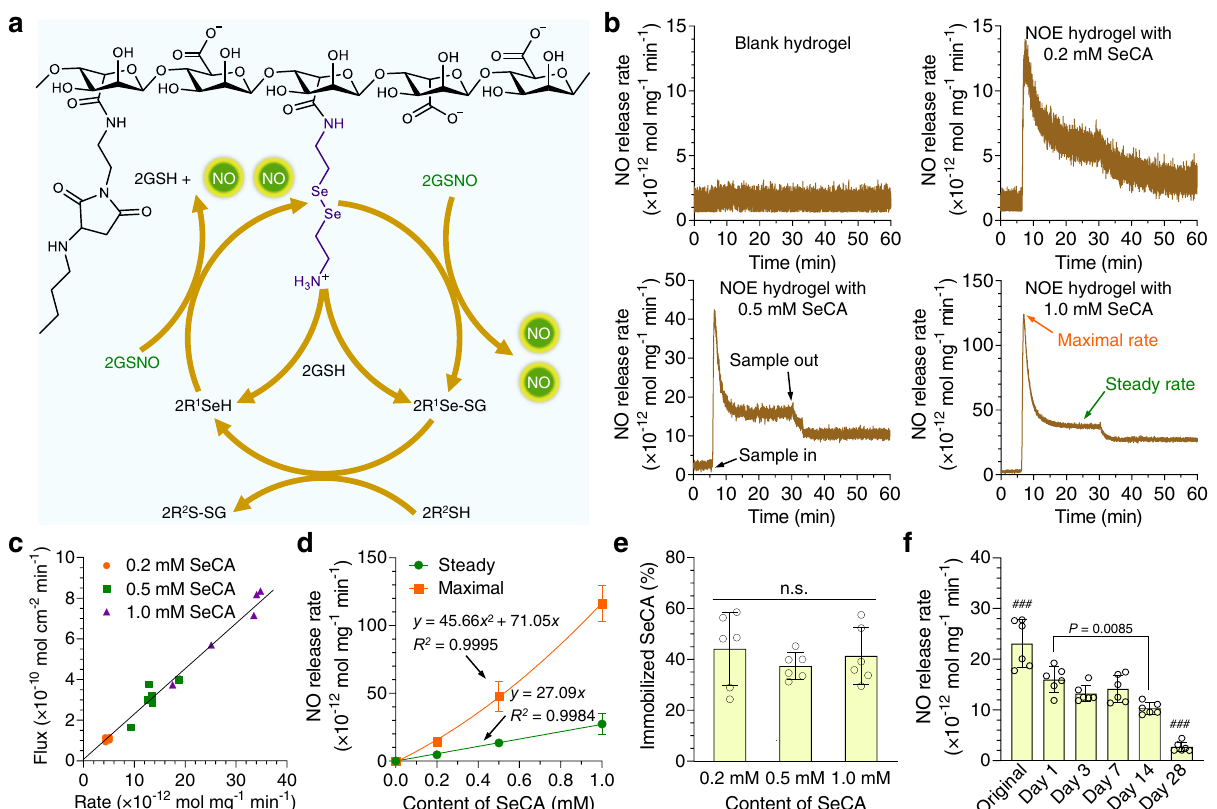
Fig. 3 Catalytic generation of nitric oxide (NO) in the hydrogel. a Mechanism on the catalytic generation of NO from NO donors (R ’ S-NO) by selenocystamine (SeCA) conjugated to alginate. b Representative curves of NO generation from S-nitrosoglutathione (GSNO, 10 μ M in PBS at 37 °C) catalyzed by the nitric oxide-eluting (NOE) hydrogels conjugated with varying contents of SeCA (0.2 – 1.0 mM). c Correlation between the fl uxes and rates of NO generation. d Summary on the release features of NO catalyzed by the NOE hydrogels (mean ± SD, n = 6 independent samples). e Quanti fi cation of the immobilized SeCA in the NOE hydrogels after catalytic generation of NO (mean ± SD, n = 6 independent samples). f Release rates of NO from GSNO catalyzed by the NOE hydrogel conjugated with 1.0 mM SeCA after preincubation in PBS at 37 °C for different durations (mean ± SD, n = 6 independent samples). One-way analysis of variance (ANOVA) with Tukey post hoc test was performed to determine the difference among various groups. ( n.s. not signi fi cant, ### P < 0.001 compared with other